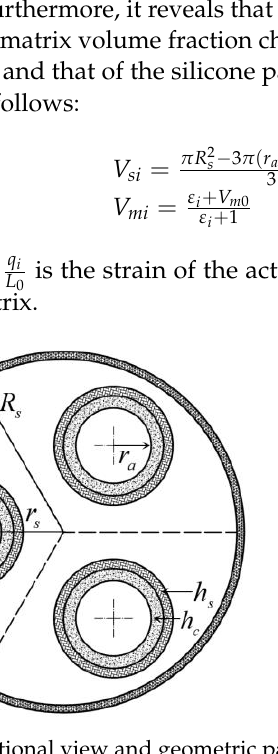
Figure 5. Sectional view and geometric parameters of the soft joint. The visco-hyperelastic constitutive model proposed for the soft actuator is described by a system of a non-Newtonian viscous damper and a hyperelastic spring in parallel, which is equivalent to the simplified Kelvin–Voigt model [41]. Therefore, σ in (19) includes hyperelastic stress σ h and viscous stress σ v